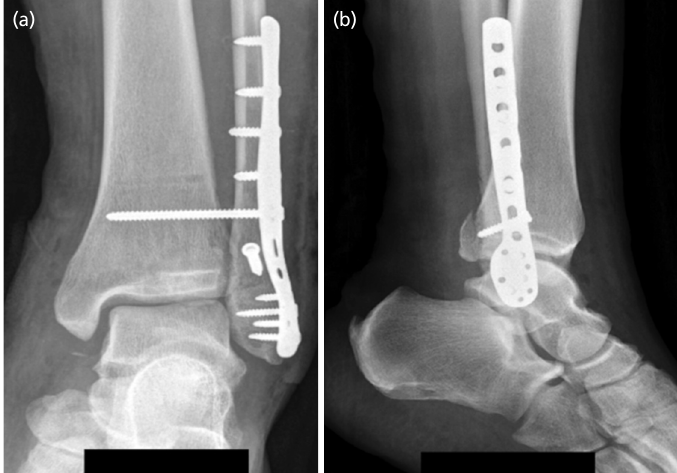
Fig. 4: Patient 2 – Post-operative (a) antero-posterior and (b) lateral radiographs of the ankle at six